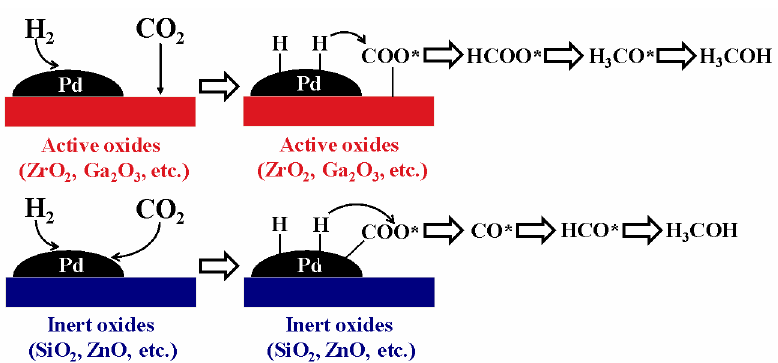
Figure 6. Schematic reaction mechanism of CO 2 hydrogenation over Pd-based catalysts with addition of different oxides.